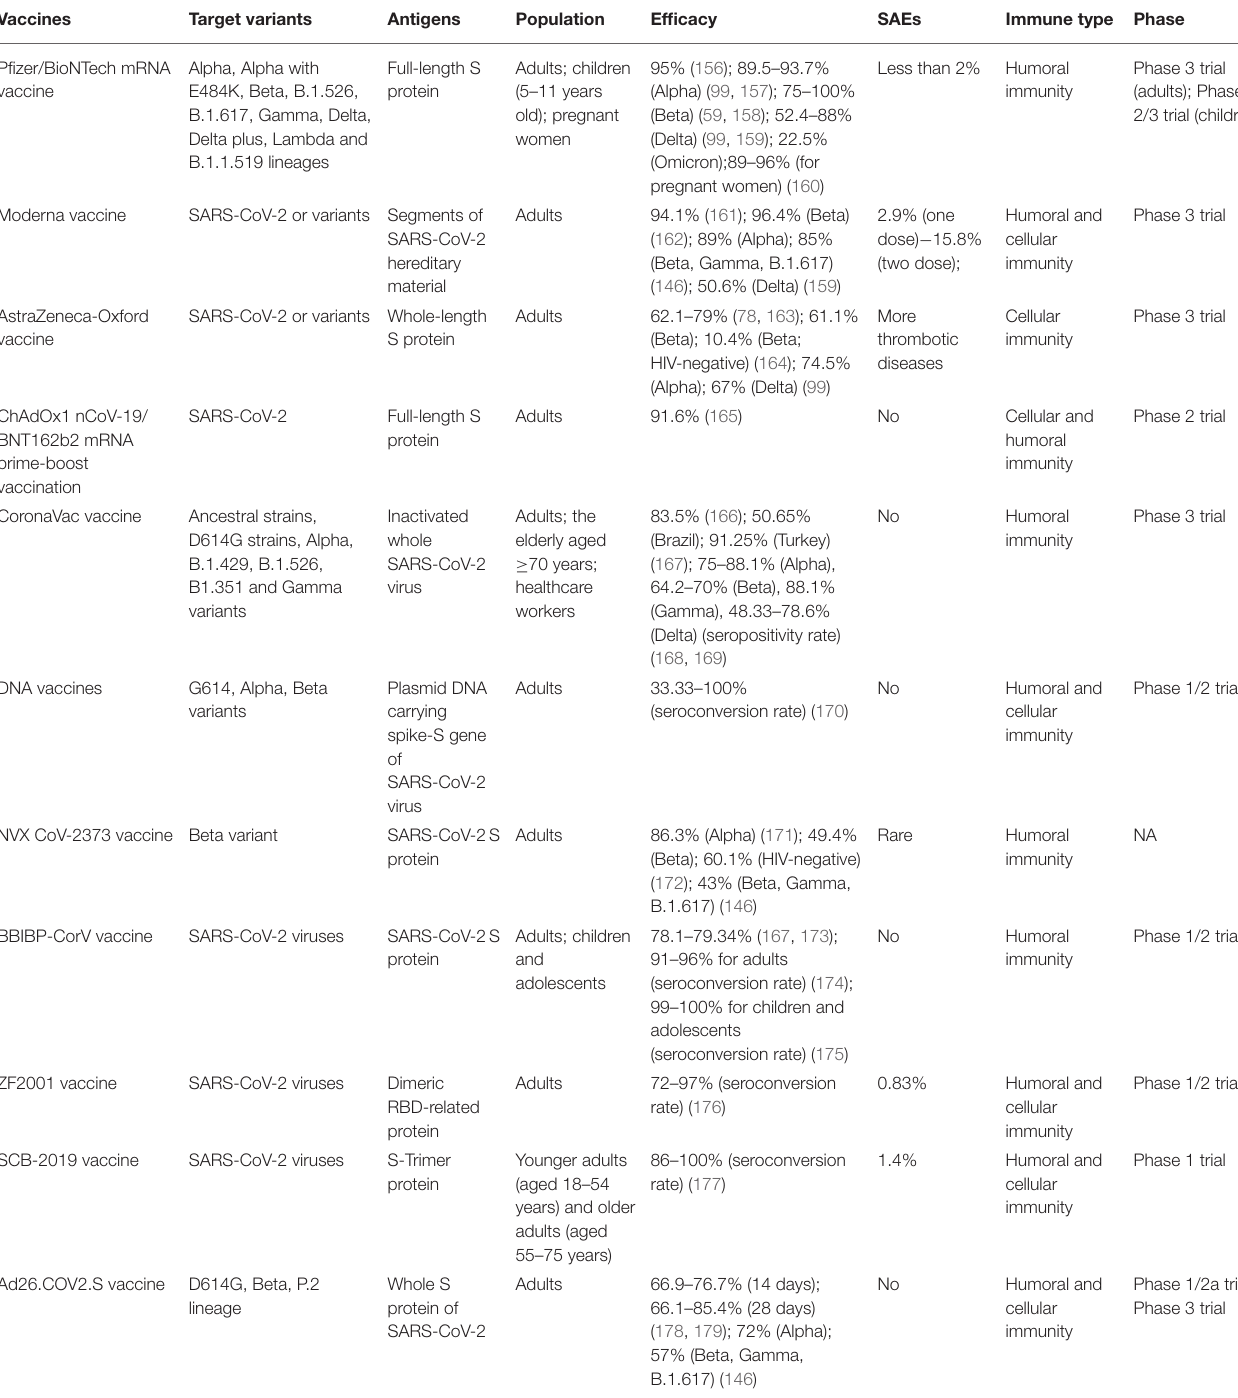
TABLE 3 | The basic clinical characteristics of current